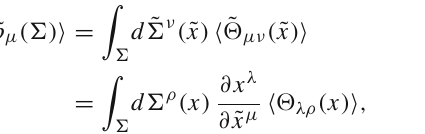
plot shows (cid:7) p z ( t ) (cid:5) / (cid:7) p t ( t ) (cid:5) . Point-like particles move with the group velocity, in particular, ˙ z ( t ) = p z ( t )/ p t ( t ) (the black solid curve). The mismatch between (cid:7)˙ z ( t ) (cid:5) and (cid:7) p z ( t ) (cid:5) / (cid:7) p t ( t ) (cid:5) becomes non-negligible if M / H (cid:6)